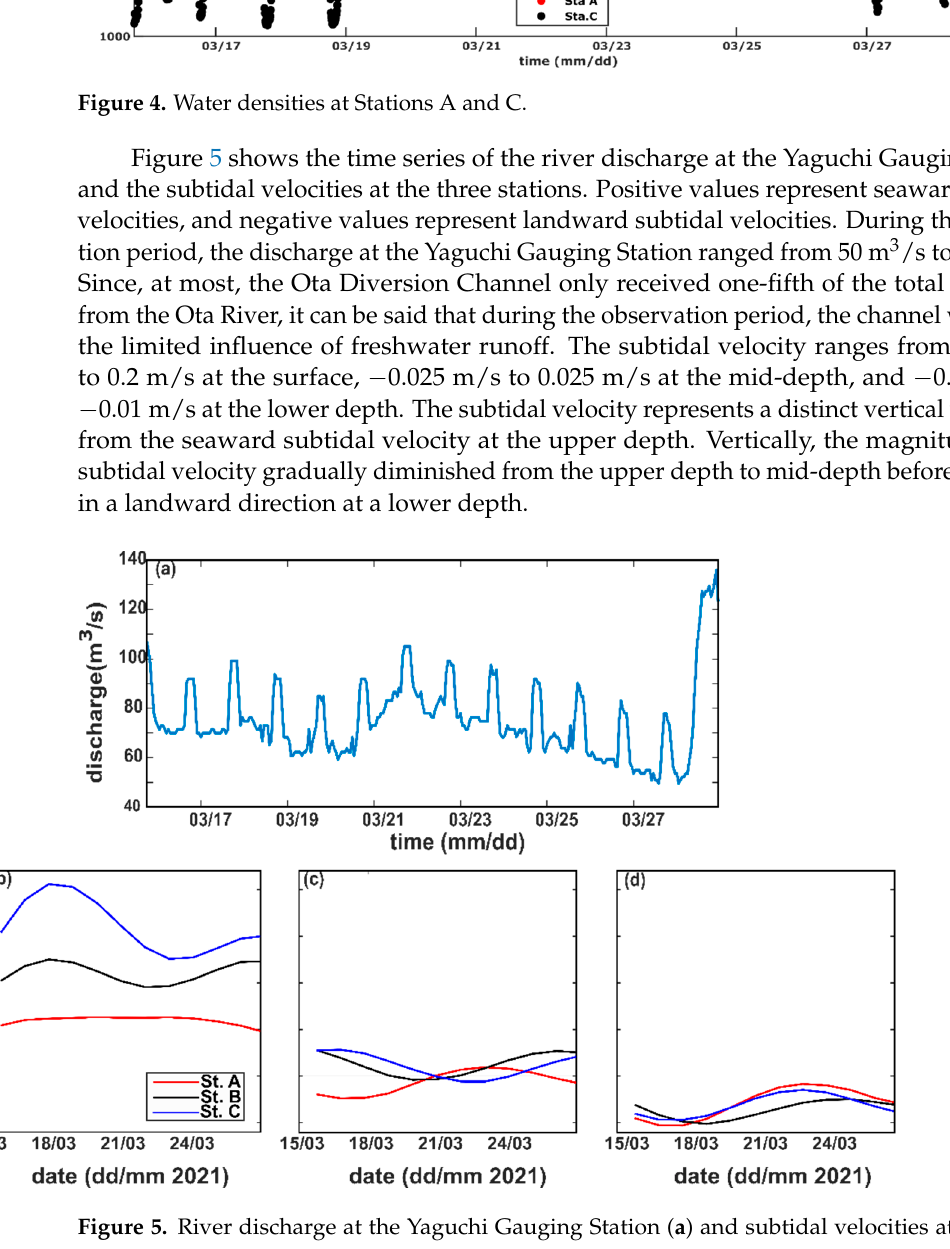
Figure 4. Water densities at Stations A and C.